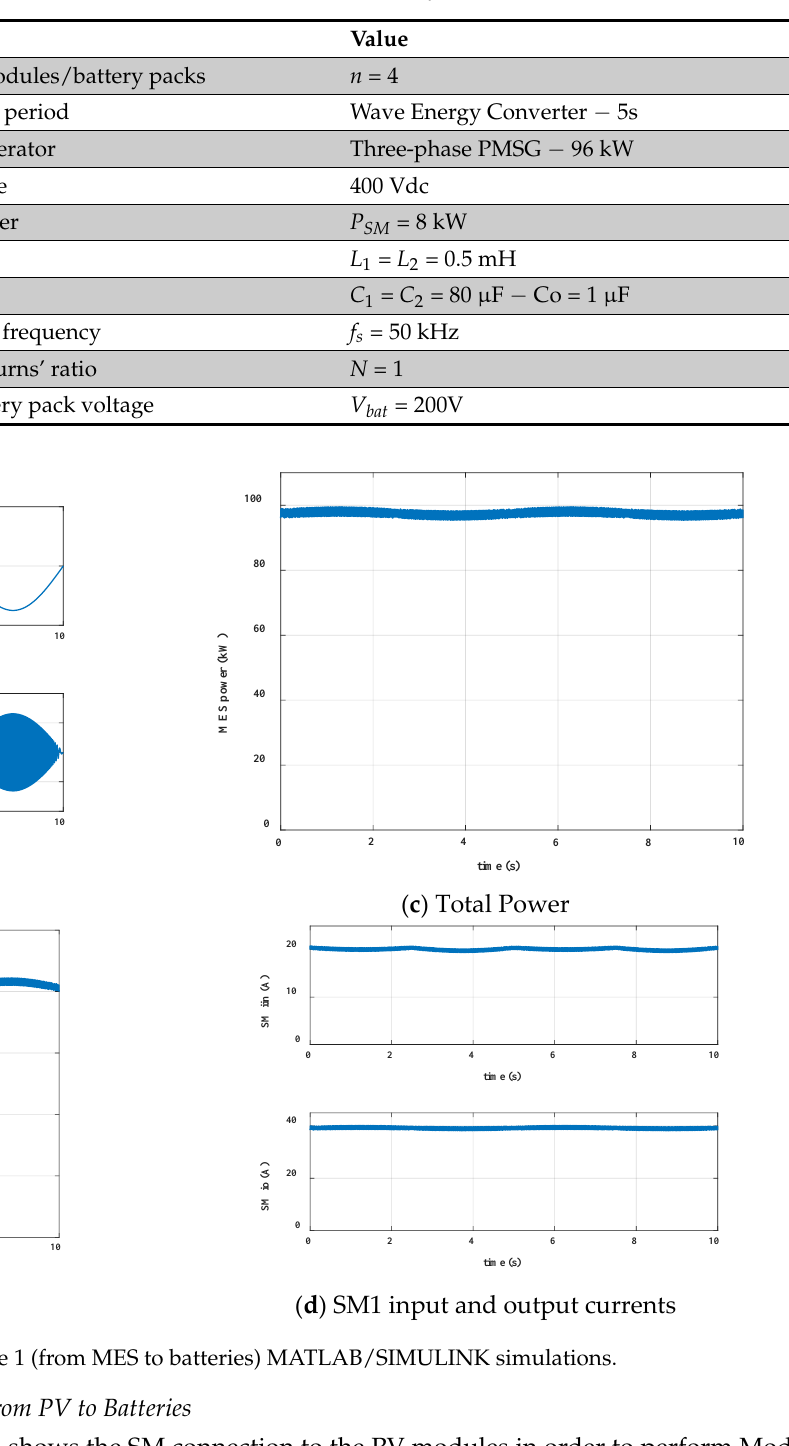
Table 2. Parameters of the SIMULINK/MATLAB case study for Mode 1.